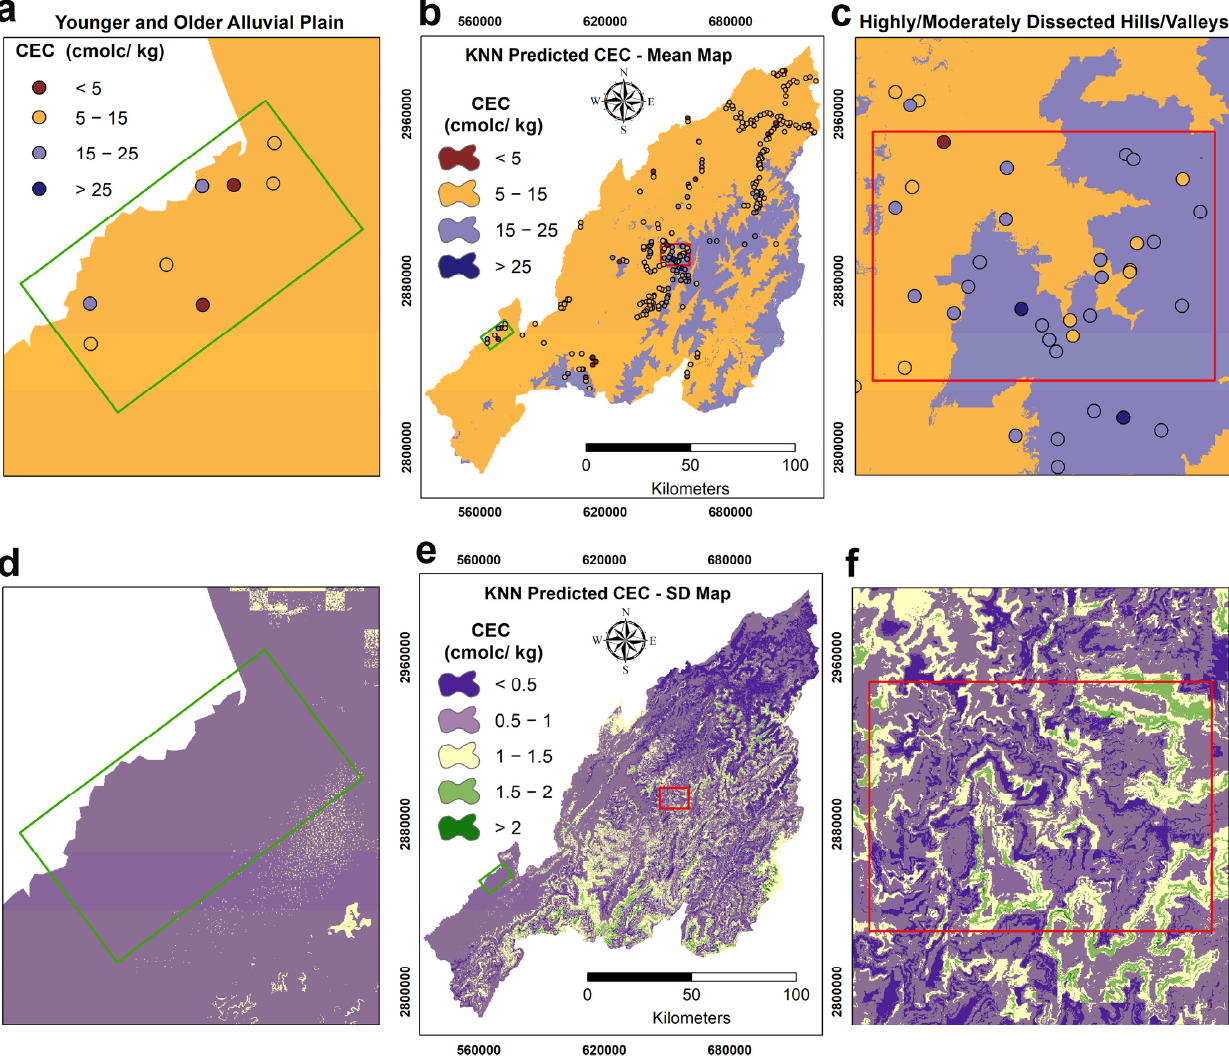
Figure 9. Digital maps of CEC (0–30 cm) were generated by applying a K-nearest neighbors (KNN) model: Zoomed to a young and older alluvial plain area as mean CEC map ( a ) and as uncertainty CEC map ( d ); mean CEC map over Nagaland ( b ) resulting from the prediction among 10 iterations; zoomed to a highly/moderately dissected hills and valleys as mean CEC map ( c ) and as uncertainty CEC map ( f ); uncertainty CEC map over Nagaland ( e ) resulting from the standard deviation of 10 iterations.